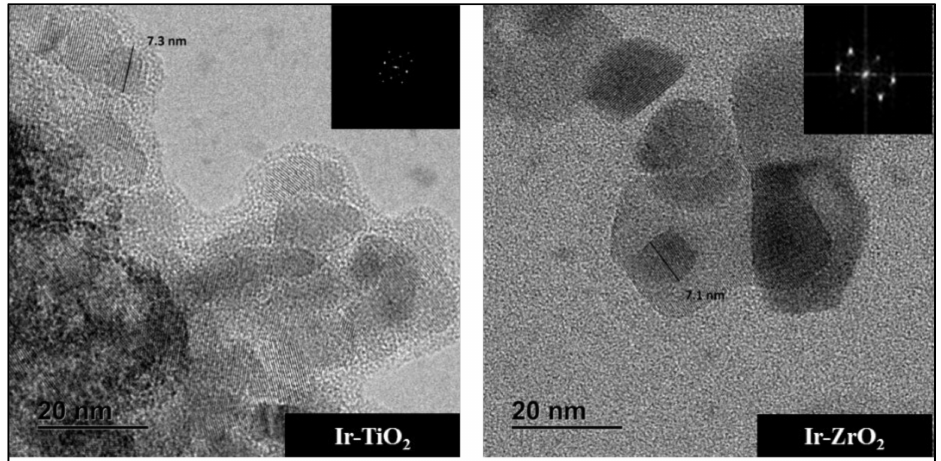
Figure 7. HRTEM images of the Ir catalysts (Inset: selected area